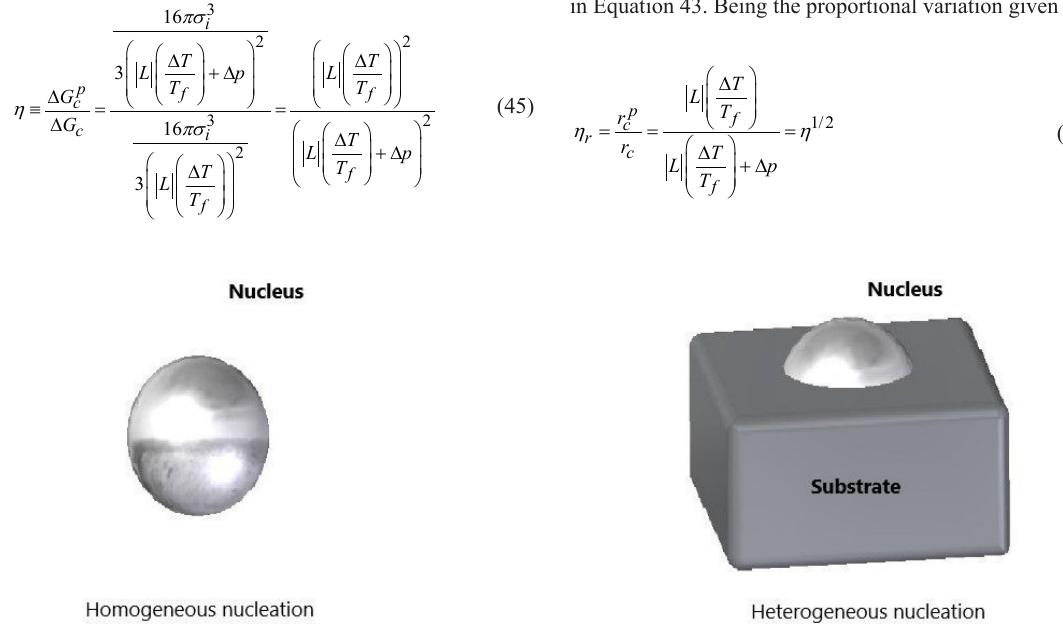
Figure 5. Schematic representation of heterogeneous and homogeneous